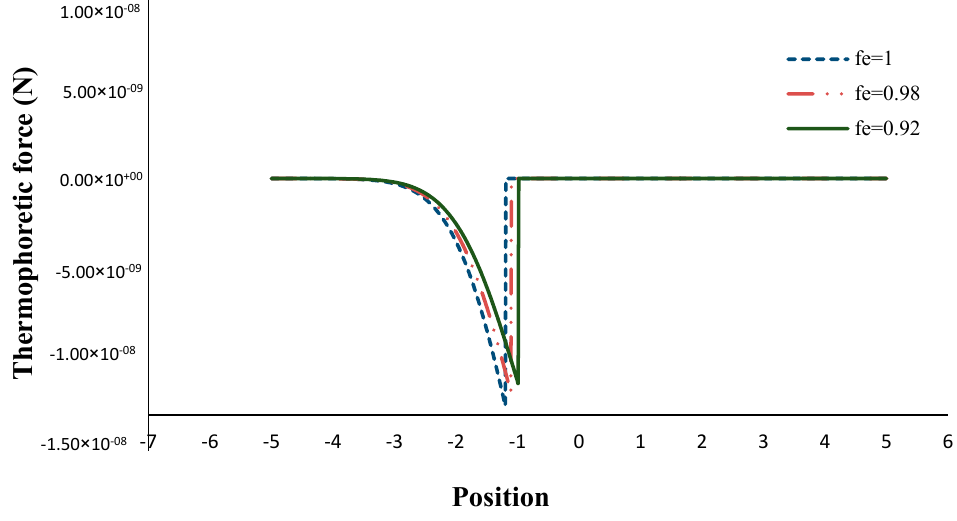
Figure 17. Thermophoretic force against position for different porosity factors.